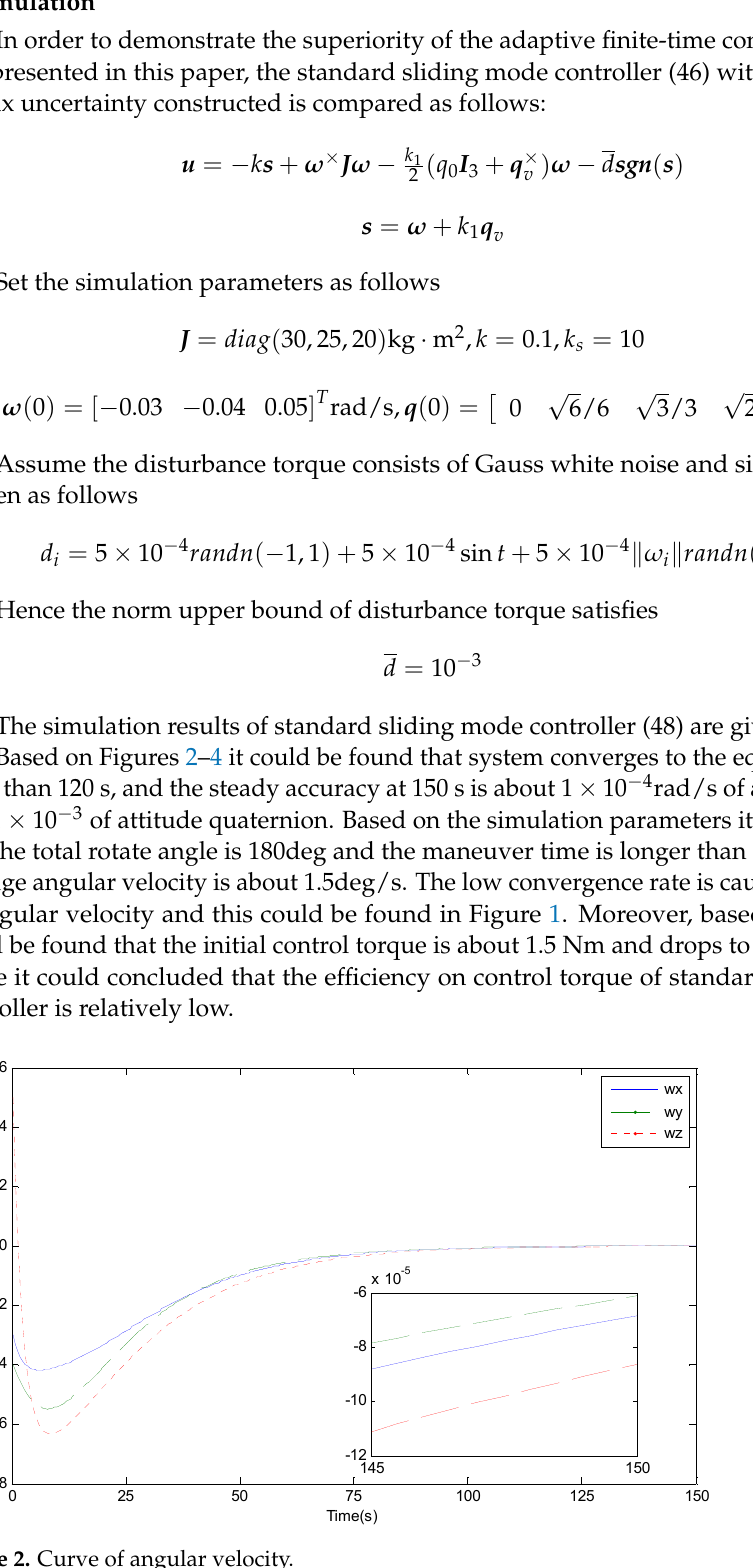
Figure 2. Curve of angular velocity.